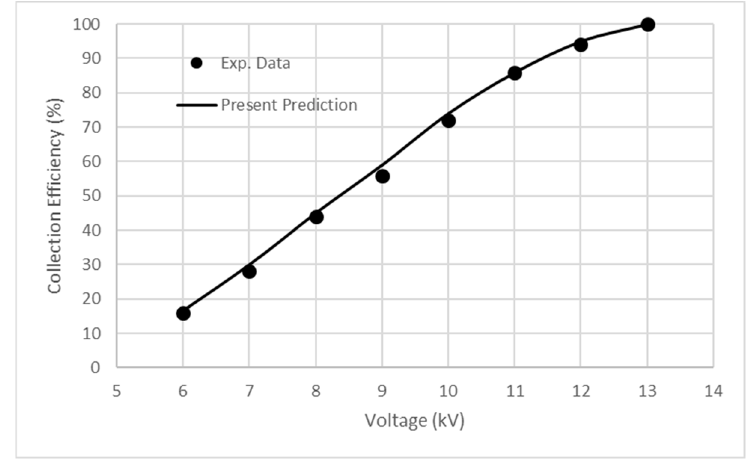
Figure 4. Comparison of collection efficiency values with the experimental data.